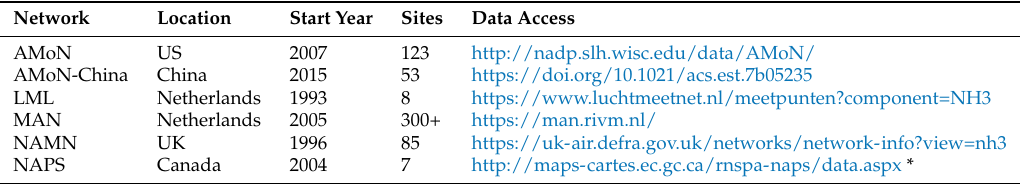
Table 1. Details of long-term [NH 3 ] measurement networks and their data access